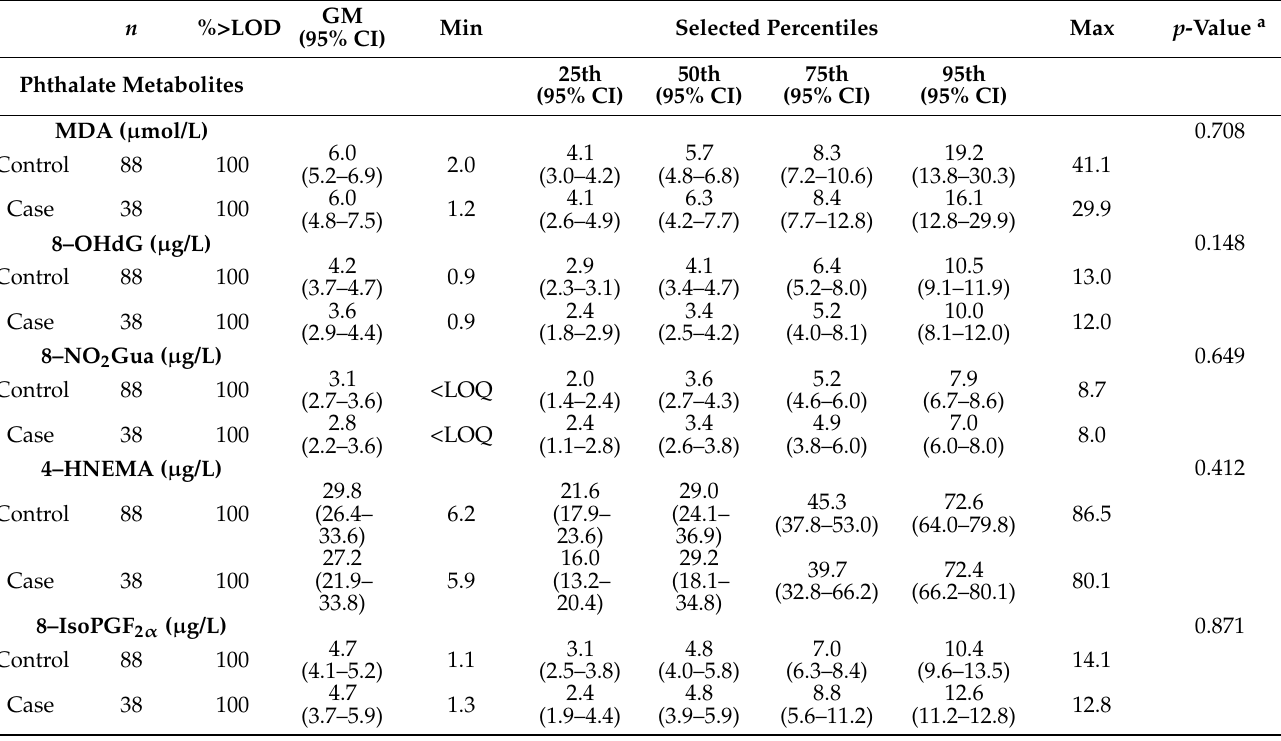
Table 3. Levels of oxidative/nitrosative stress biomarker for control and case